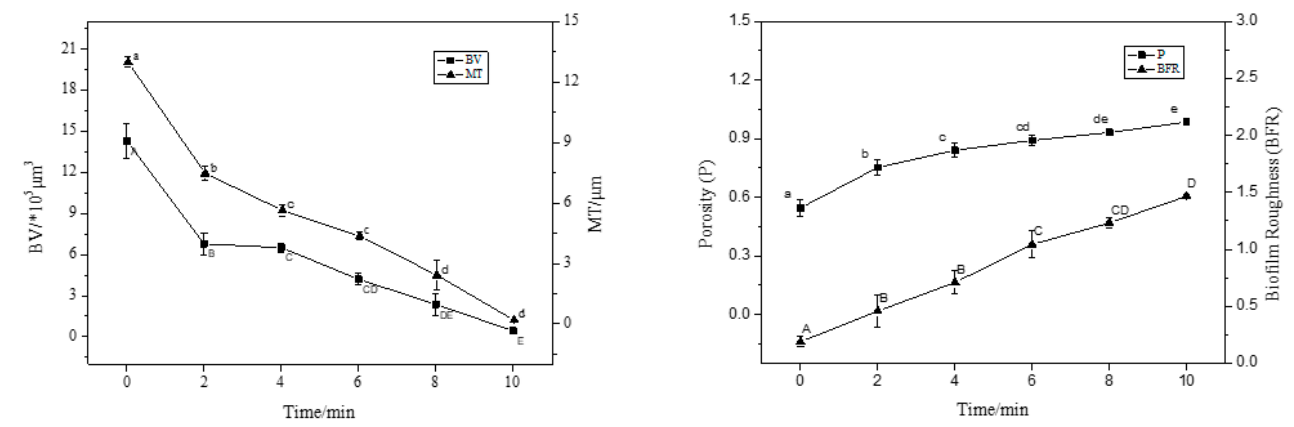
Figure 11. The CLSM images analysed by ISA-2 software to determine the biovolume (BV), mean thickness (MT), porosity (P) and biofilm roughness (BFR) of the biofilm. Data were expressed by mean measurements ± standard deviation (SD) and all treatments and determinations were performed in triplicate. The different letters indicate significant differences ( p < 0.05).